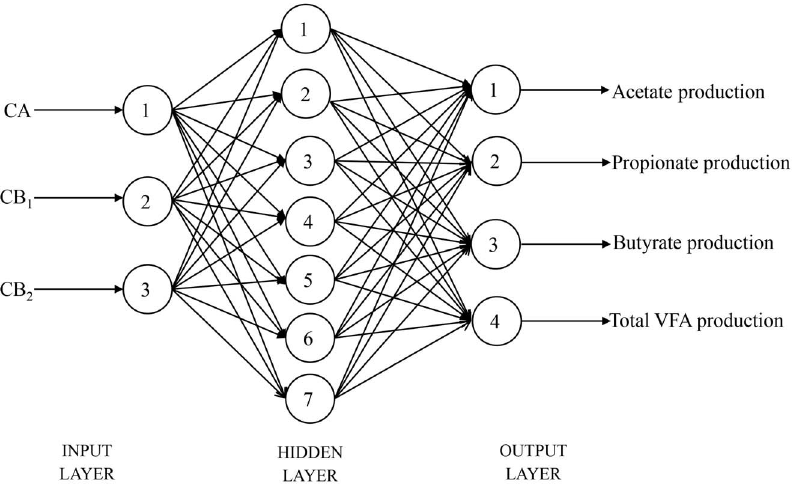
Fig. 2. The basic structure of back propagation neural network for acetate, propionate, butyrate, or total VFA production output simultaneously.